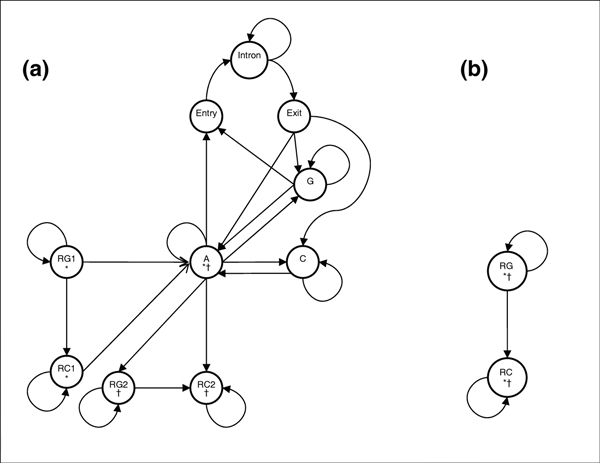
PairHMM state diagrams of Pairagon. (a) Alignment model and (b) Null model. RG1 and RG2 are unaligned genomic sequences in the 5' and 3' ends, respectively; RC1 and RC2 are unaligned cDNA sequences in the 5' and 3' ends, respectively; A, aligned; Entry corresponds to the first two bases of an intron; Exit corresponds to the last two bases of an intron; G, genomic insertion; C, cDNA insertion; RG and RC are random genomic and cDNA sequences, respectively. States that can start an alignment are marked with an asterisk and states that can end an alignment are marked with a dagger.